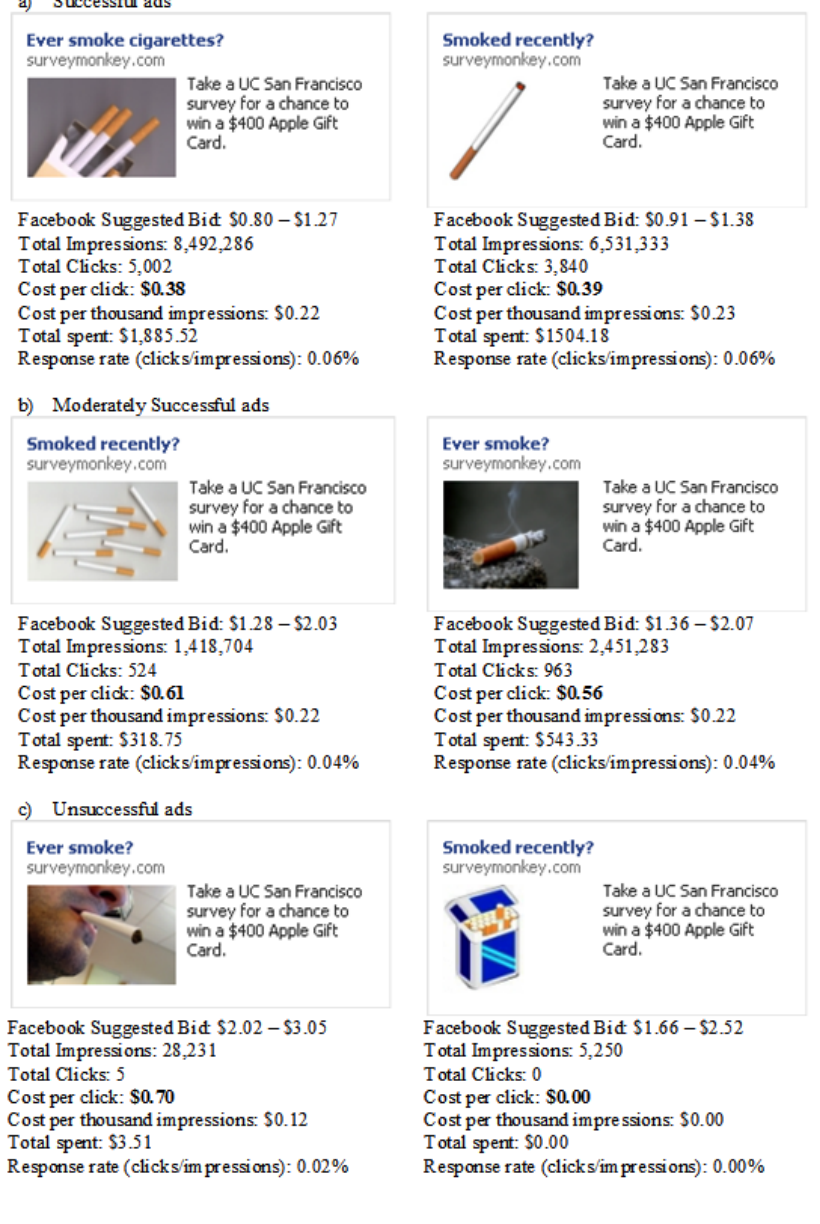
Figure 1. Examples of two successful (1a), moderately successful (1b), and unsuccessful (1c) advertisements from the Facebook campaign based on ad statistics. Reported Facebook-suggested bids are from the last day of the